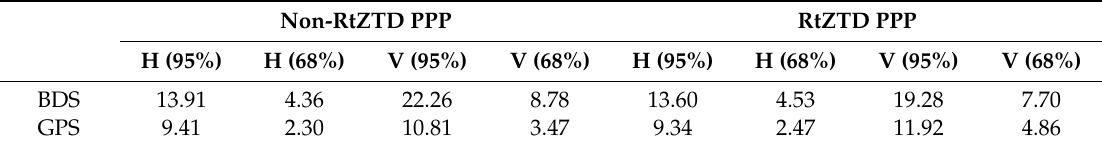
Table 6. RMS of the positioning error after convergence (the first-three-hour results removed) (unit: cm).